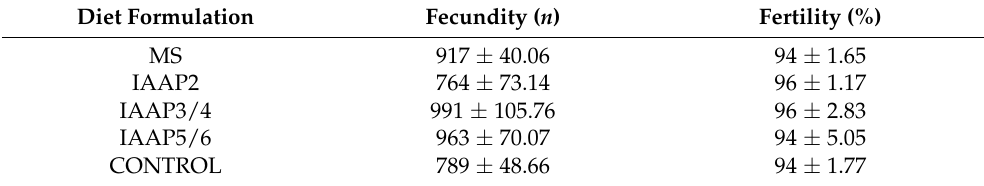
Table 8. Mean ( ± SE) fecundity of female Eldana saccharina ( n = 15) and their egg fertility after mating with moths from the same formulations, from the MS, IAAP2, IAAP3/4, IAAP5/6 and control diets. Diet